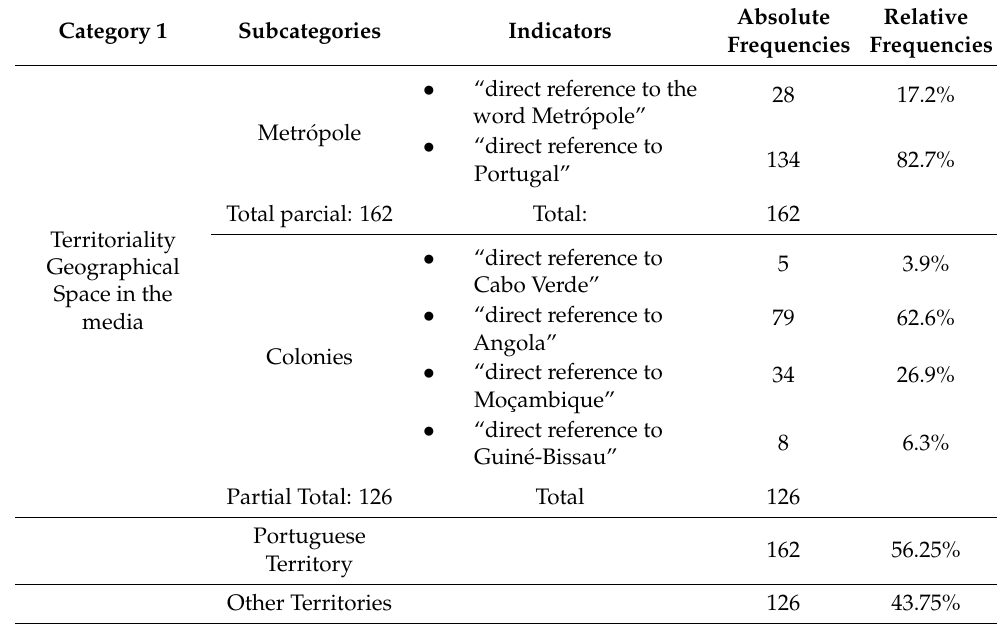
Table 2. Absolute and relative frequencies for the “Territoriality” category.